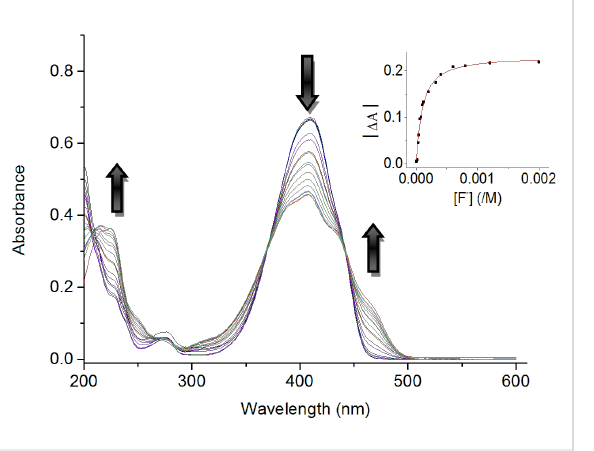
Figure 3: Emission spectral changes of BIP (4 × 10 − 7 M) in CH 3 CN upon addition of 0–20 equiv TBAF. Insert: Linear plot of emission intensity at 376 nm against fluoride concentration.